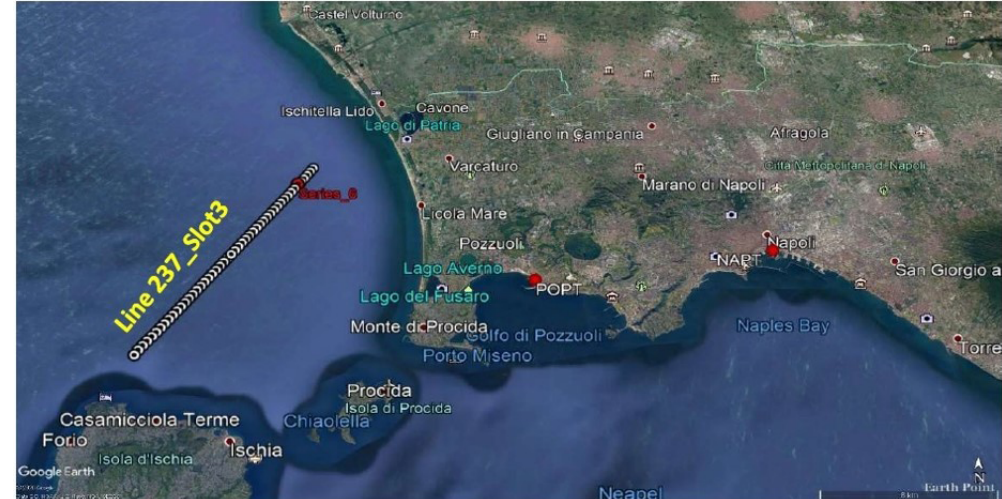
Figure 12. Location of the Line 237_Slot 3 of Jason radar altimetry. Map from Google Earth © Google Earth 2000.